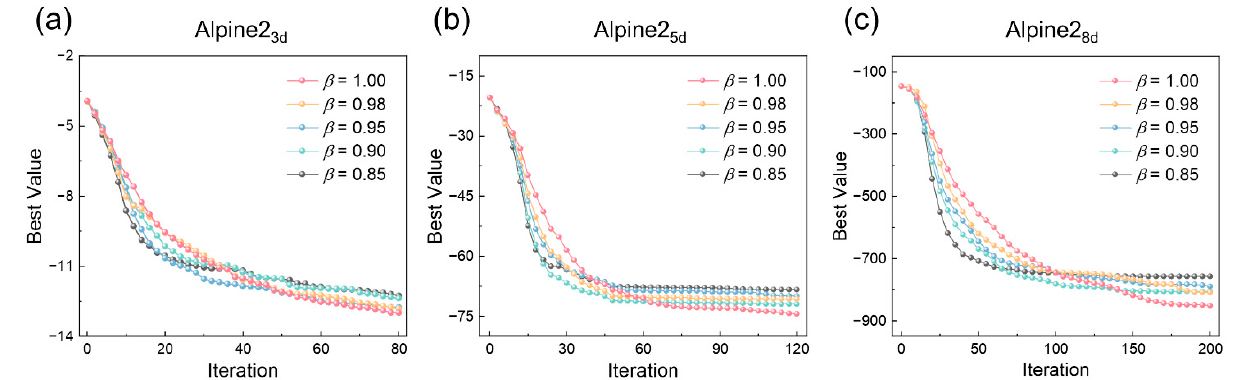
Figure 5. The average BODO performance with different 𝛽 settings (1.00, 0.98, 0.95, 0.90, and 0.85) on ( a ) alpine2 3d , ( b ) alpine2 5d , and ( c ) alpine2 8d test functions. BODO is run for 10 times over 10 random initial point sets. The initial point sets are the same for all 𝛽 settings.